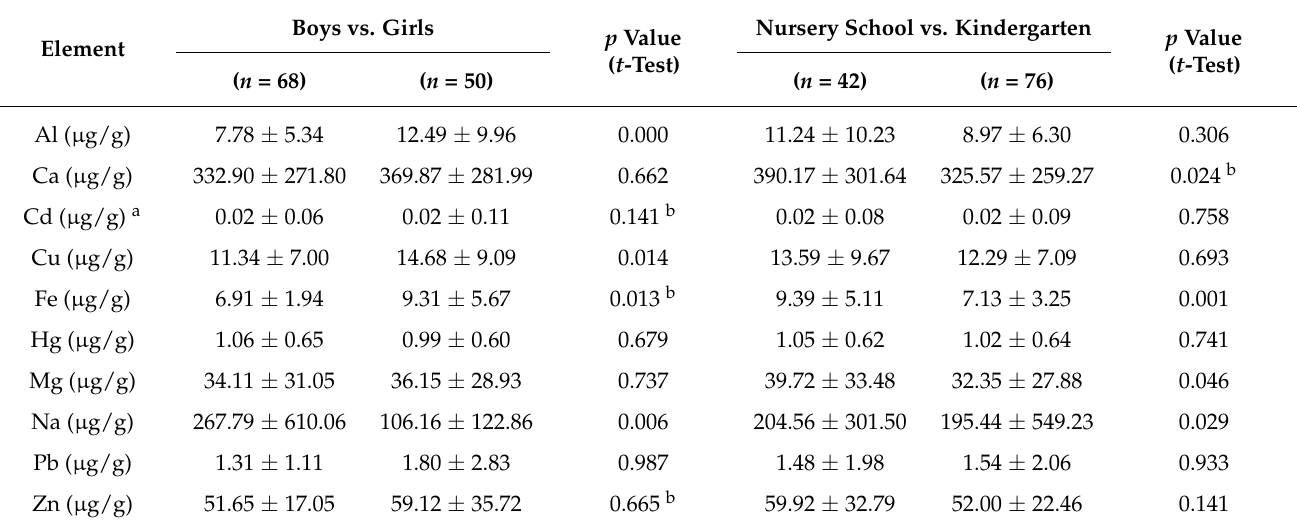
Table 5. Mean and standard deviation in the hair of boys and girls in Japanese children. Boys vs. Element